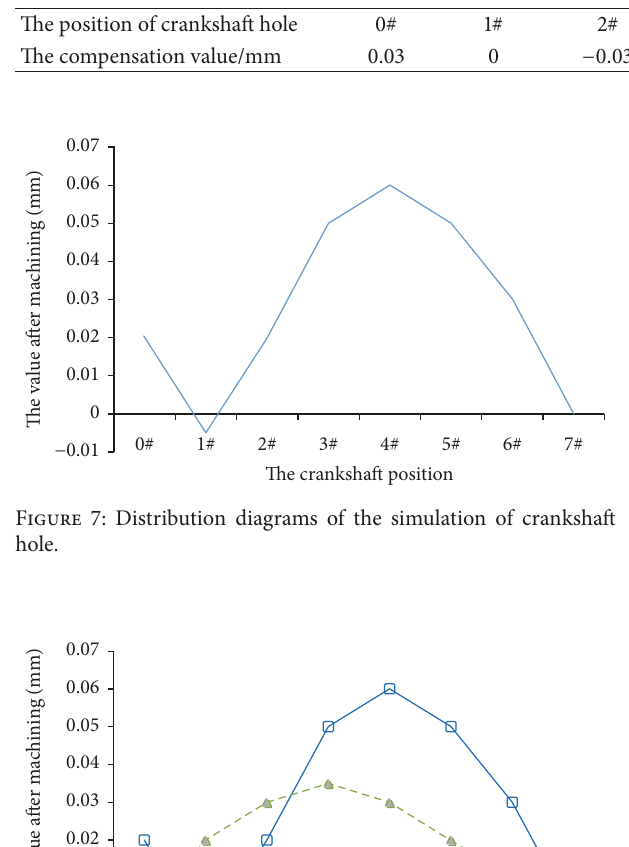
Figure 10: The distribution diagram of crankshaft hole of sample